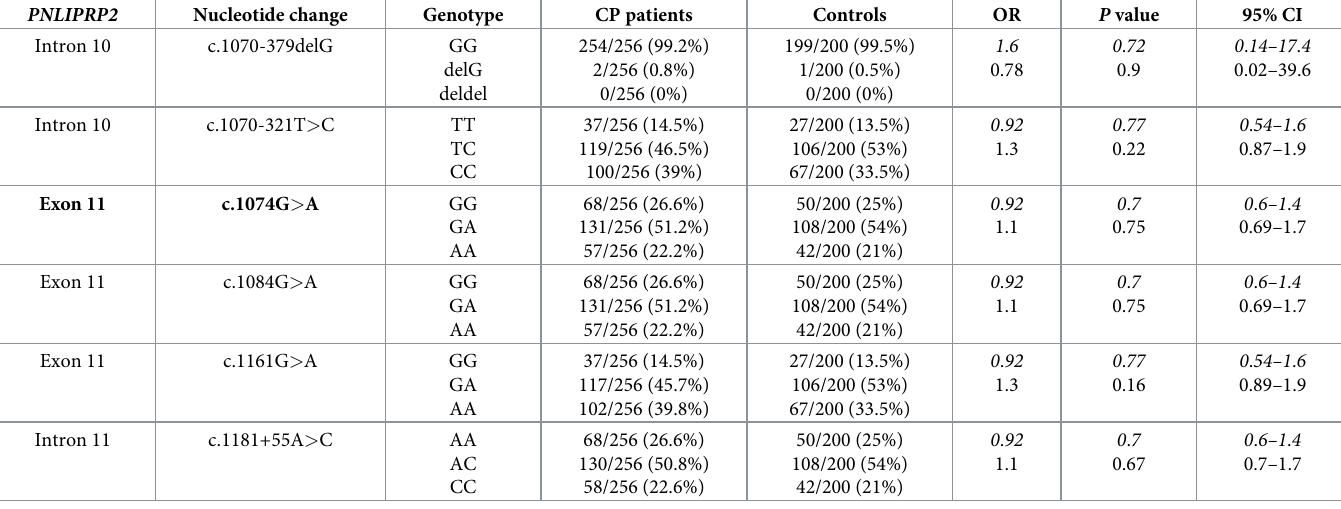
Table 7. Genotype distribution of PNLIPRP2 variants in patients with chronic pancreatitis (CP) and in controls.